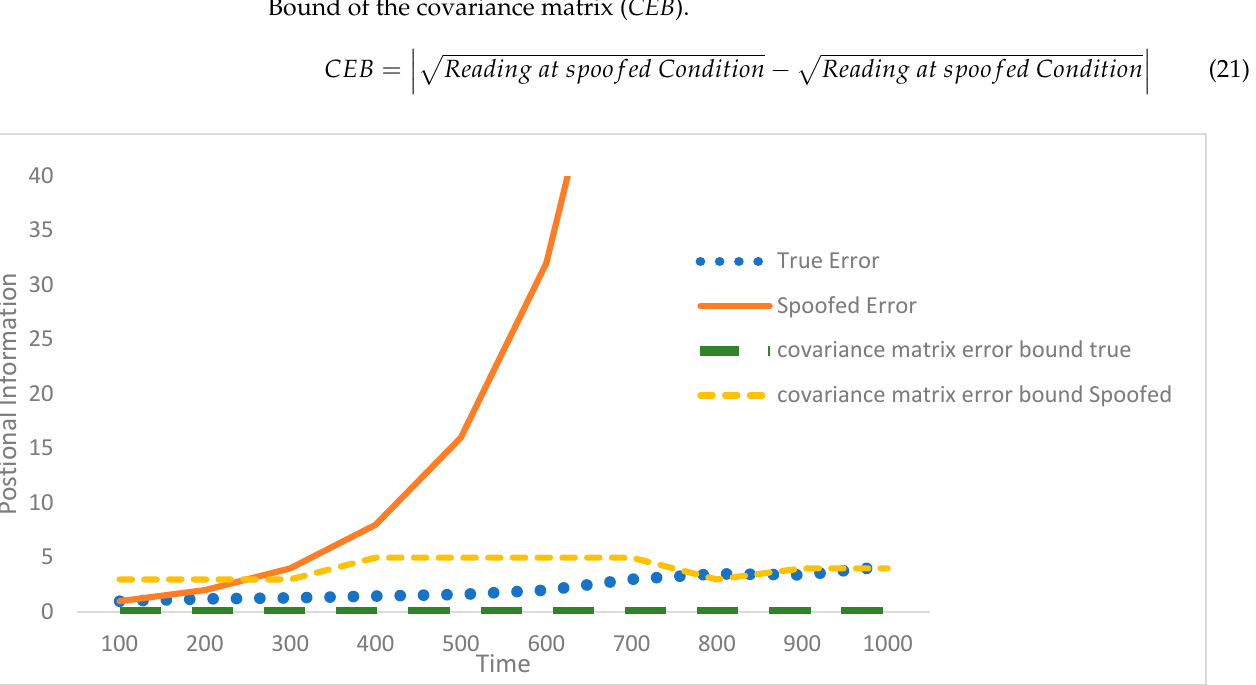
Figure 11. Error covariance matrix to check the effect of Monte Carlo simulation spoofing attack of different densities for high-intensity attack.